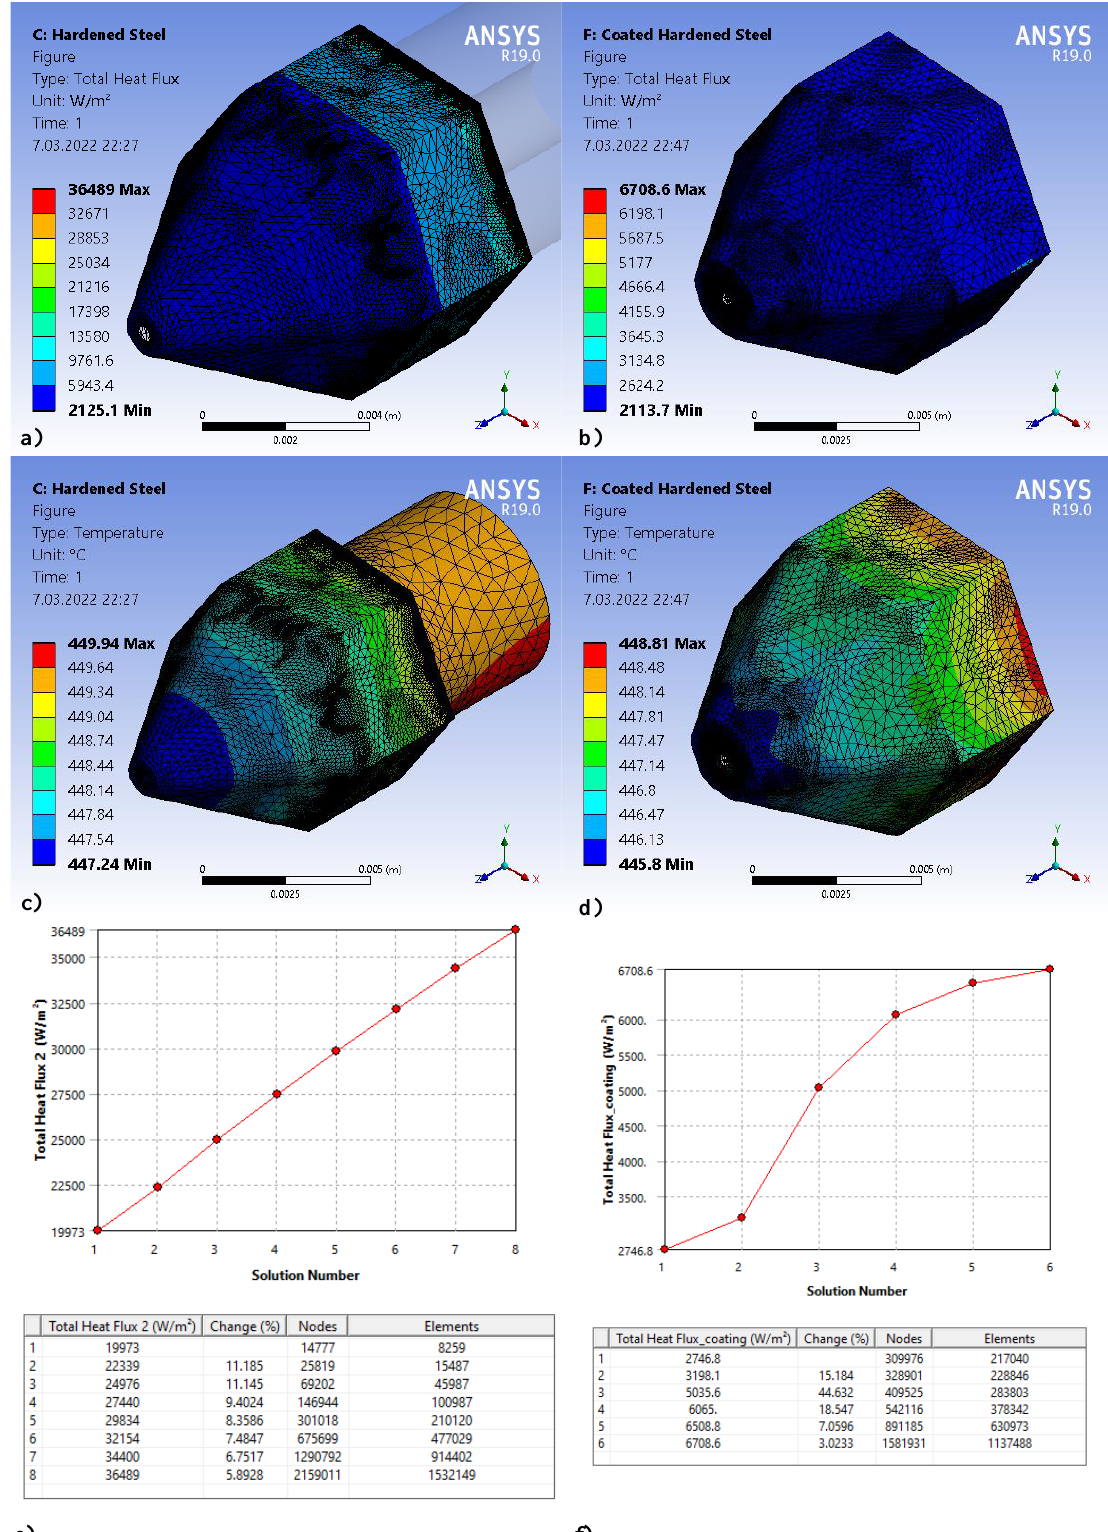
Figure 6. The total heat flux of ( a ) the hardened steel nozzle and ( b ) the coated hardened steel nozzle; temperature distribution of ( c ) the hardened steel nozzle and ( d ) the coated hardened steel nozzle; mesh convergence study based on the total heat flux of ( e ) the hardened steel nozzle and ( f ) the coated hardened steel nozzle.